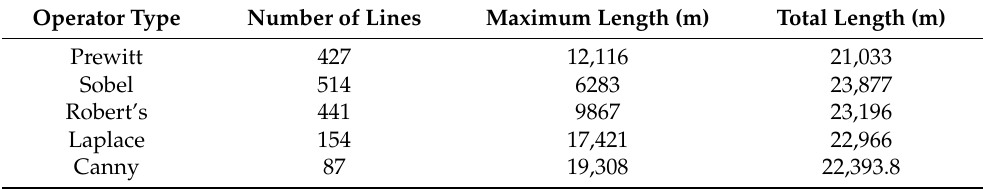
Figure 14. ( a ) represents sample area a; ( b – f ) represent the extraction results of the Roberts, Prewitt, Sobel, Laplace, and Canny operators, respectively. Table 4. Comparison of evaluation index values of different edge detection